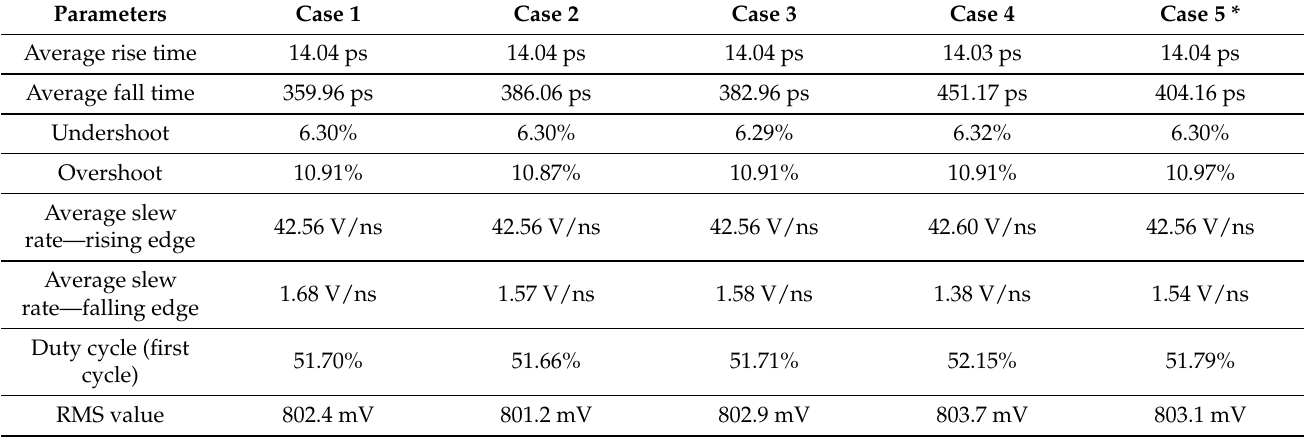
Table 5. Data for transient measurement under various